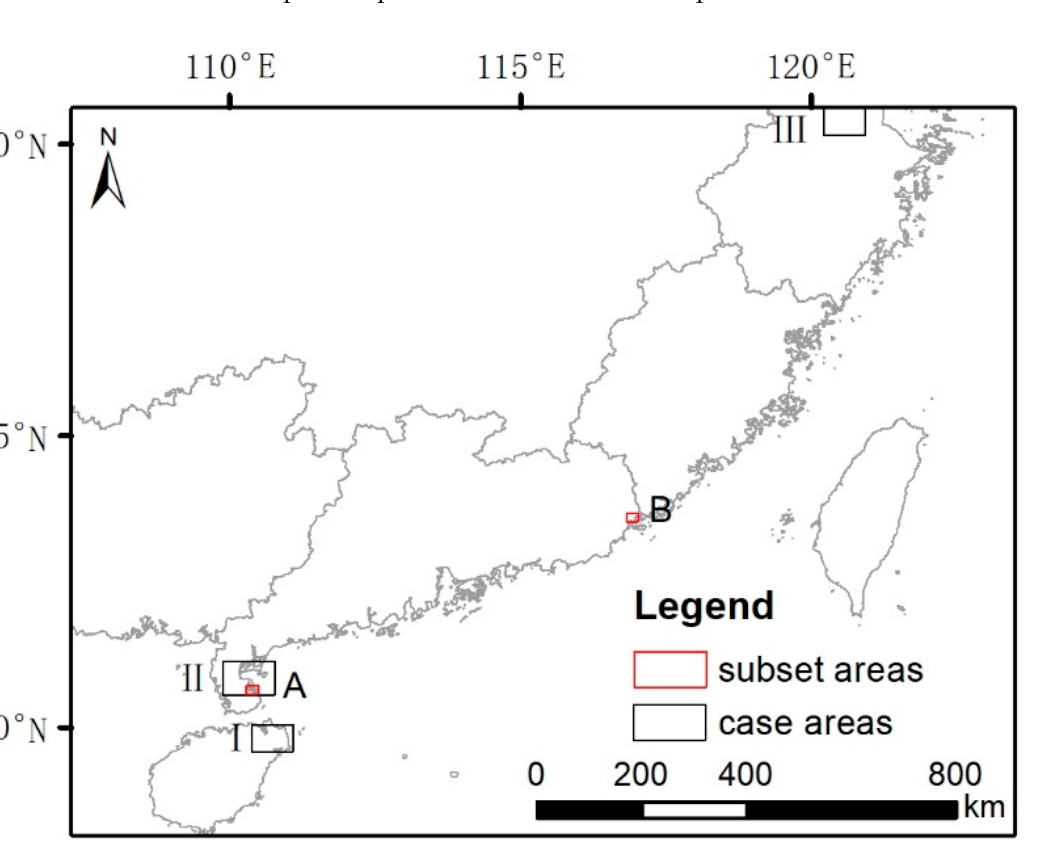
Figure 5. Locations of selected case areas and subset areas. The case areas are annotated with I, II, and III near the left of the black frames, covering the mangrove-rich area in Hainan, the mangrove-rich area at the estuary in Guangdong, and the non-mangrove area at the estuary in Zhejiang. The subset areas, with the annotation of A and B near the right of the red frames, are smaller than case areas, to depict the direct classifications in detail. The subset area A is a coastal area with complex land covers, and the subset area B is dominated by